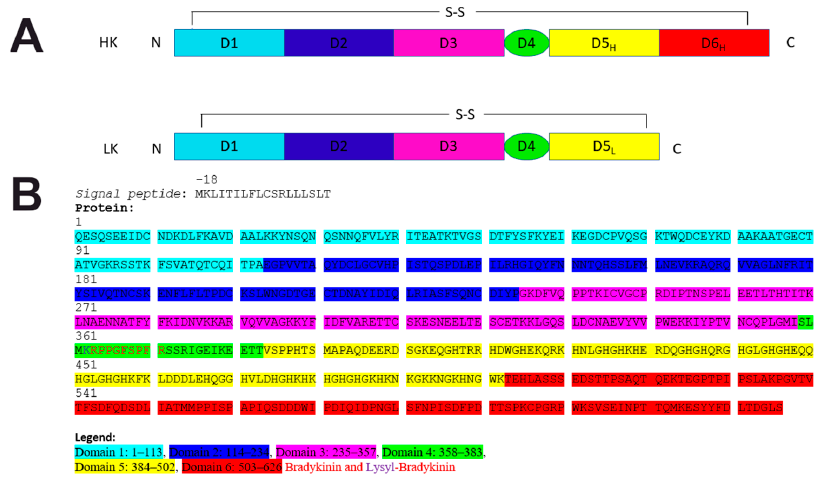
Figure 2. ( A ) Human plasma kininogen showing alternative splicing products of KNG1 gene messenger RNA–HK and LK. Both forms of protein have similar D1, D2, D3, and D4 domains, but different D5 domains. Domain 6 is absent in LK and the molecular weight of this form is lower than that of HK. ( B ) Human HK amino acid sequence according to UniProt P01042 with the indication of domains. N-terminus and C-terminus marked by corresponding letters. Disulfide (SS) bonds between the respective domains are